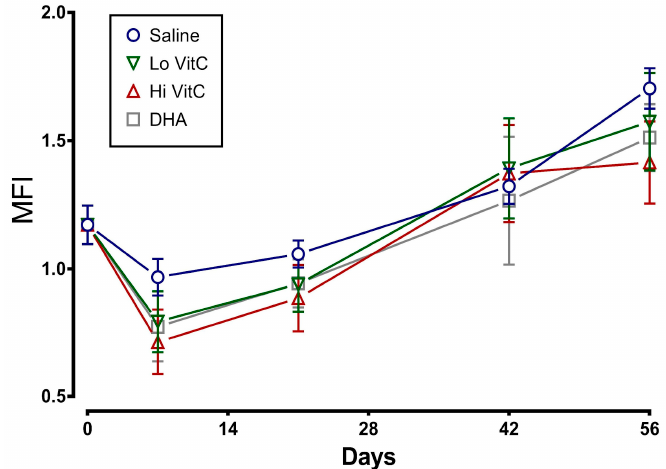
Figure 3. Effect of VitC exposure on the MFI of RBC. MFI of RBC treated with saline increased over 56 days of storage. The addition of reduced VitC (Lo/Hi) or oxidized VitC (DHA) reduced the MFI of treated RBC. However, this decrease did not reach statistical significance. ( N = 5/group, p > 0.05).